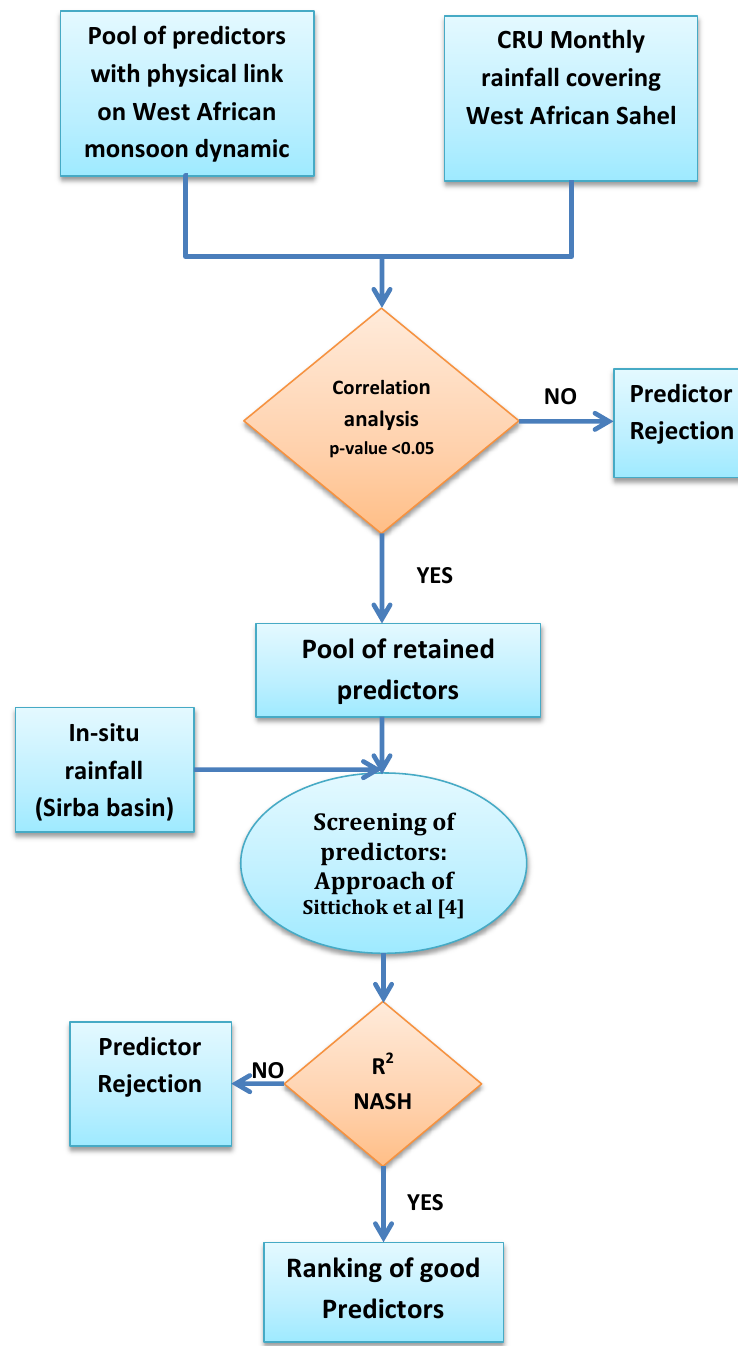
Figure 3. Steps for the selection of